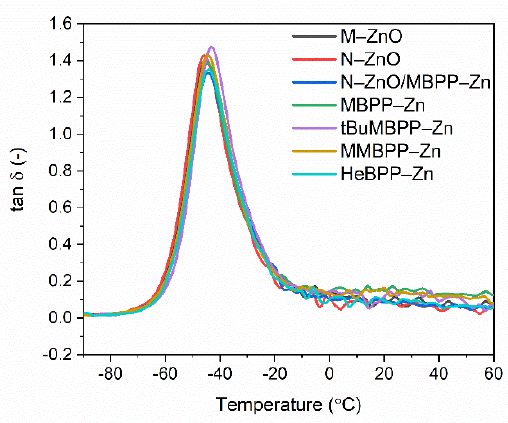
Figure 11. Loss factor (tan ∆ ) curves versus temperature of SBR vulcanizates containing ZnO and zinc complexes with 1,3-diketones as activators. Table 6. Glass transition temperature (T g ) determined by dynamic mechanical analysis (DMA) and mechanical loss factor (tan δ) of SBR vulcanizates containing ZnO and zinc complexes with 1,3-